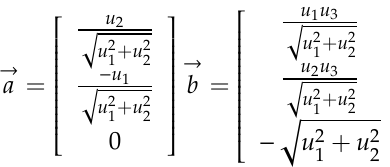
Figure 7. the density distribution of carbon fibers obtained by the method of this paper ( a ) and ( b ), and the method of randomly selecting points and vectors ( c ) and ( d ).